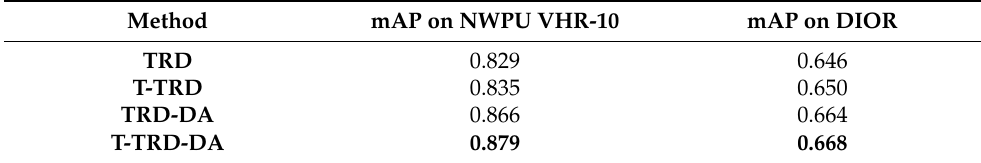
Table 5. Results of ablation